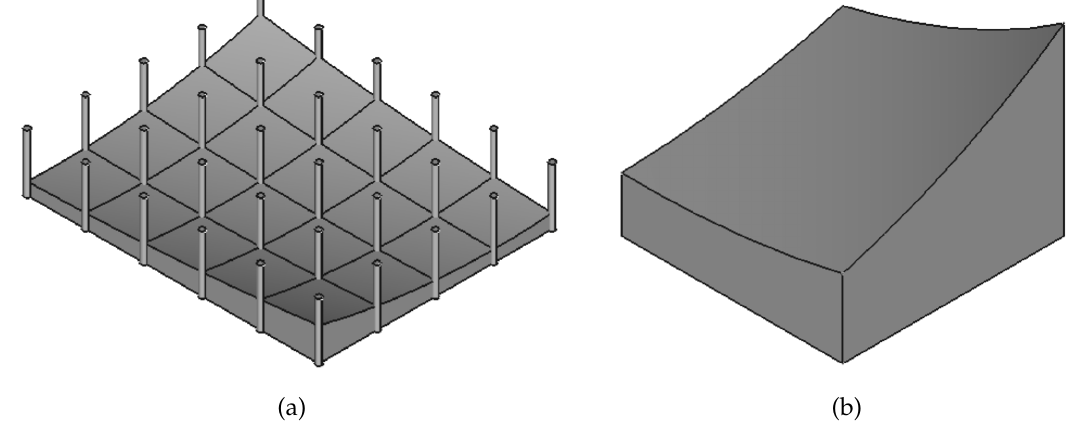
Figure 2. 3D model of ( a ) an overall portion of beach with the level variations measured by the sensor network and ( b ) of a single solid enclosed by four sensor